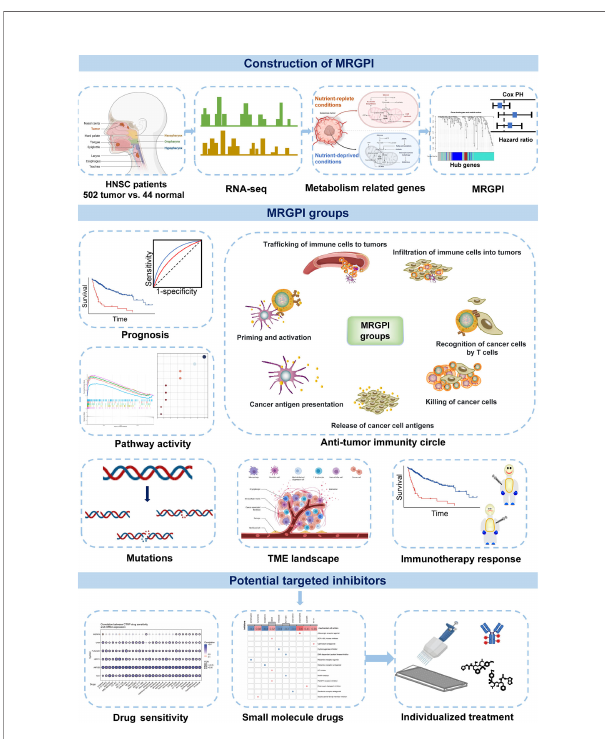
FIGURE 7 | Graphical abstract for comprehensive characterization of the MRGPI subgroups in